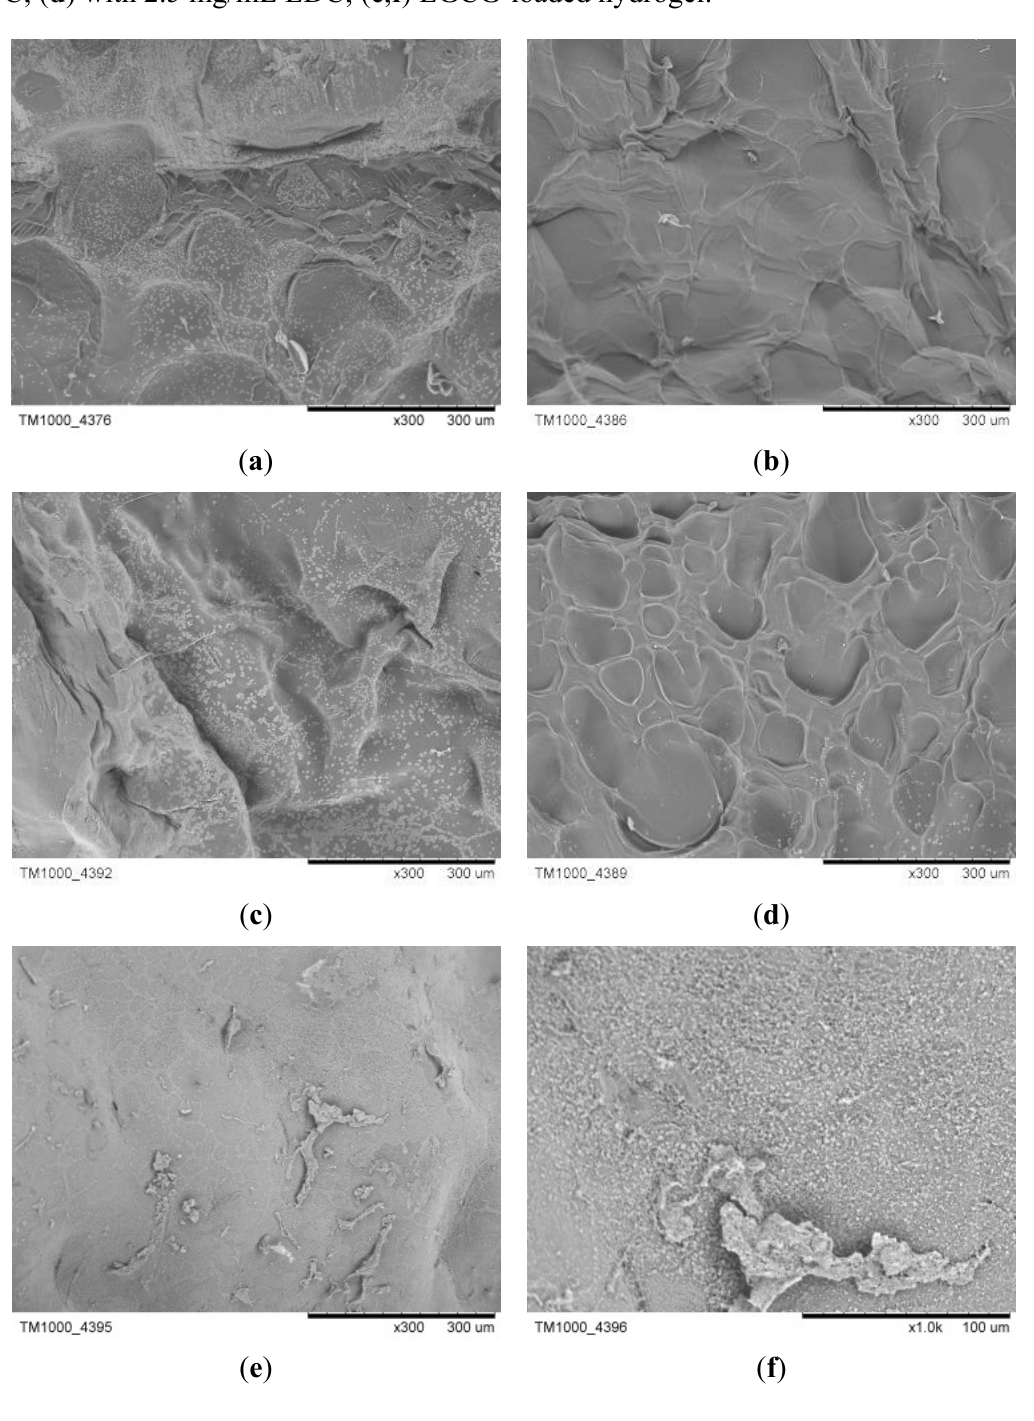
Figure 6. Scanning electron micrograph of the surface of freeze-dried hydrogel at 300× for ( a – e ) and 1000× for ( f ): ( a ) uncrosslinked; ( b ) with 0.75 mg/mL EDC; ( c ) with 1.3 mg/mL EDC; ( d ) with 2.5 mg/mL EDC; ( e , f ) EGCG-loaded